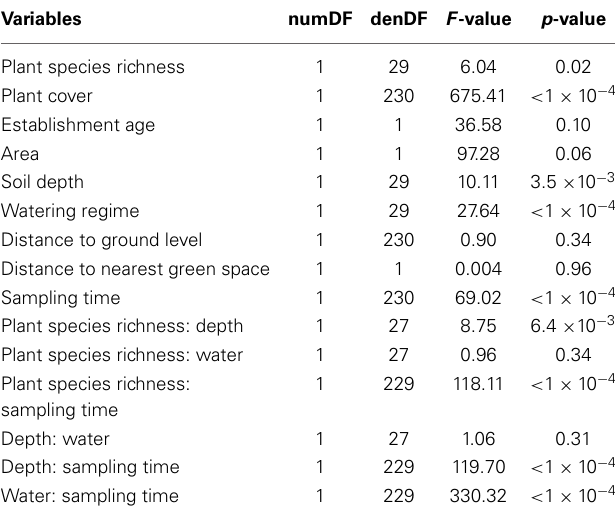
Table 5 | Results from a Wald test of a linear mixed effect model with the response variable total species richness to assess the significance of the fixed effects (i.e., sampling times, distance to green space, distance to ground level, water regime, soil depth, planter area, establishment age, plant cover and plant species richness).